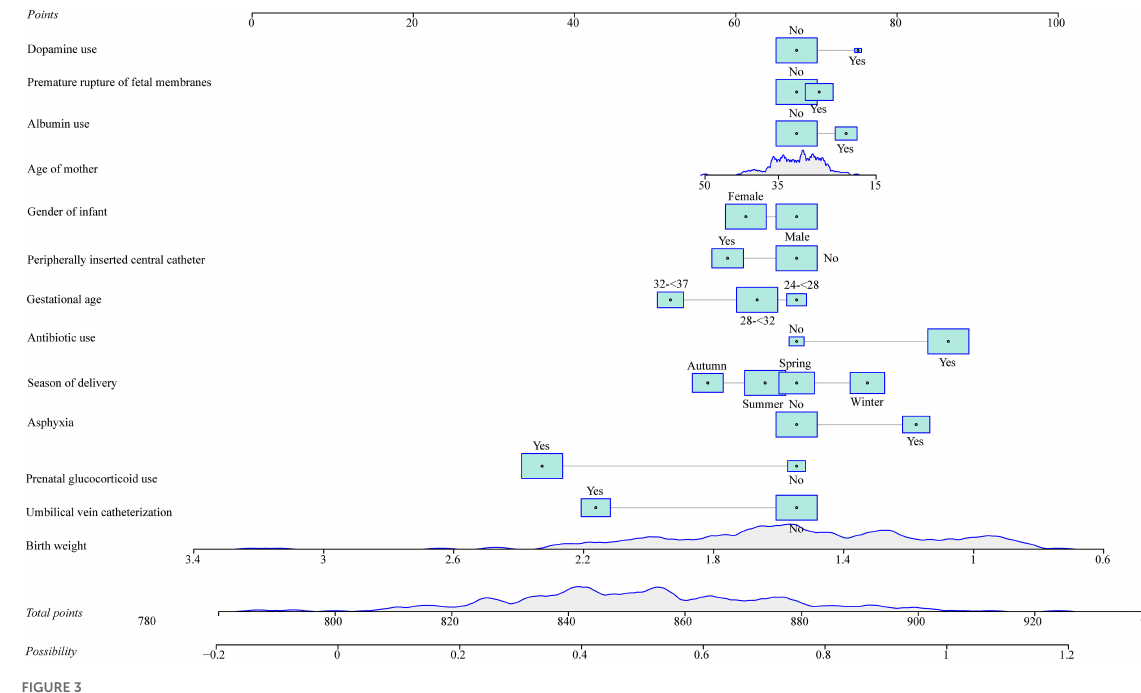
FIGURE3 The nomogram was plotted based on the prediction model.